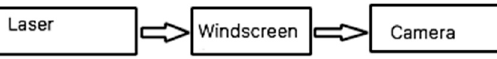
Figure 2. Diagram of the measuring system.